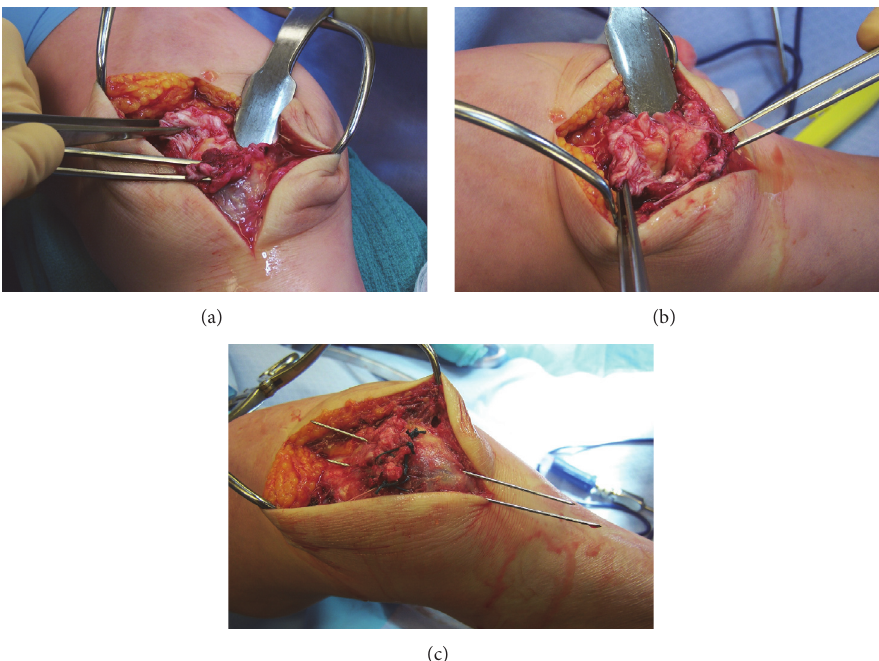
Figure 2: Surgical pictures presenting (a) the proximal and distal stumps of the ruptured intermediate tendon, (b) the use of two 1.6mm K-wires to reduce both patella parts, and (c) the tenorrhaphy protected with two K-wires.